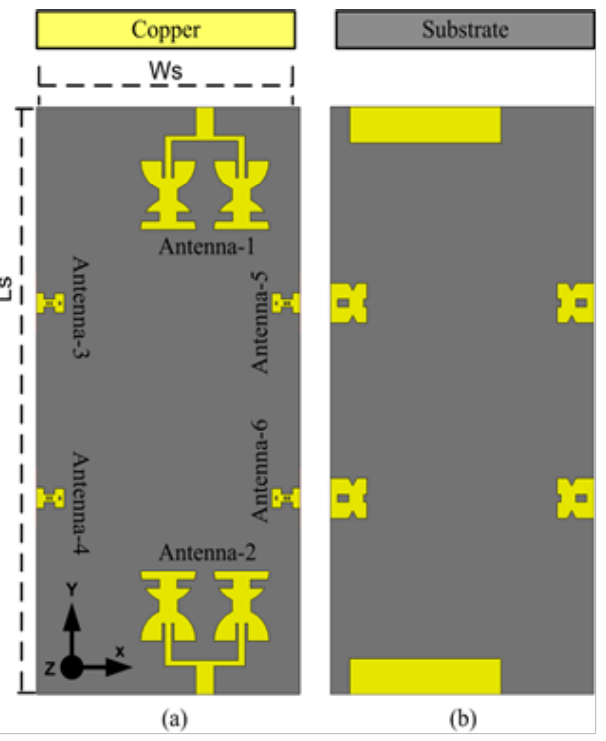
Figure 1. Geometry of the proposed integrated design: ( a ) top view; ( b ) back view.